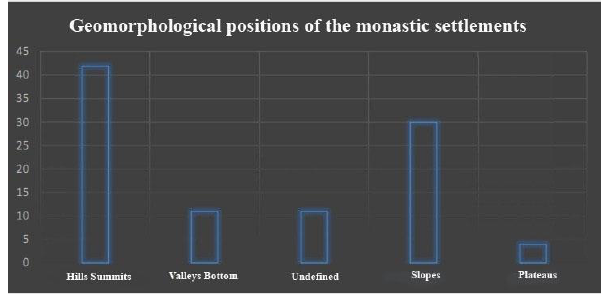
Figure 8. Geomorphological positions of the monasteries.